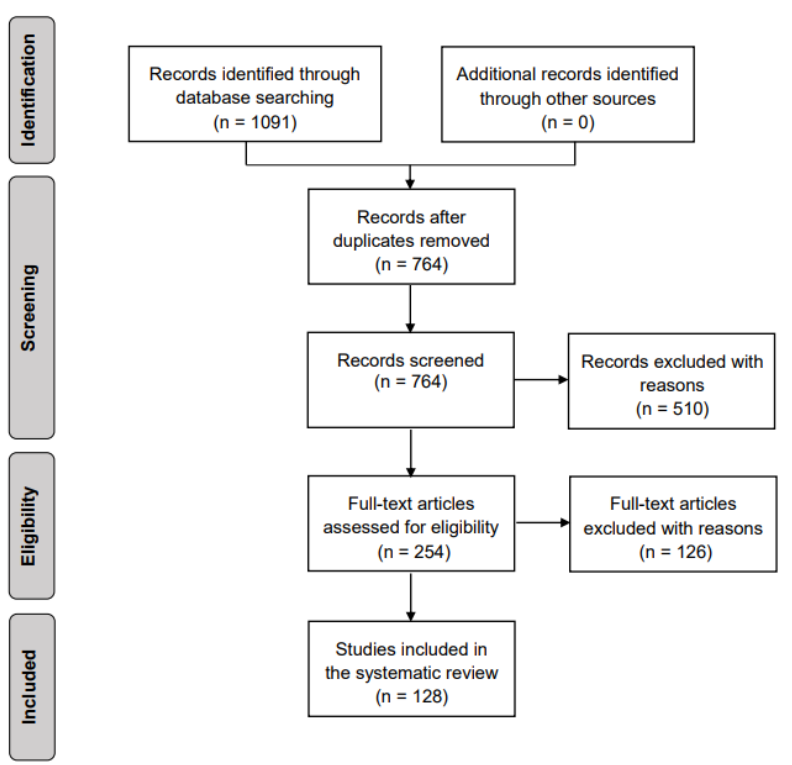
Figure 2. Flow diagram based on the PRISMA guidelines [38]. The diagram includes the four stages of a PRISMA study: identification, screening, eligibility, and inclusion.